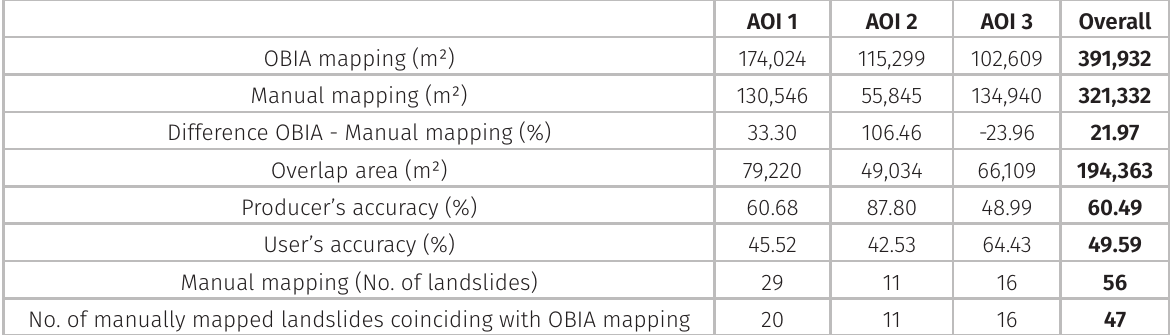
Table III. Comparison of object-based image analysis (OBIA) and manual mapping results per area of interest (AOI) and accuracy